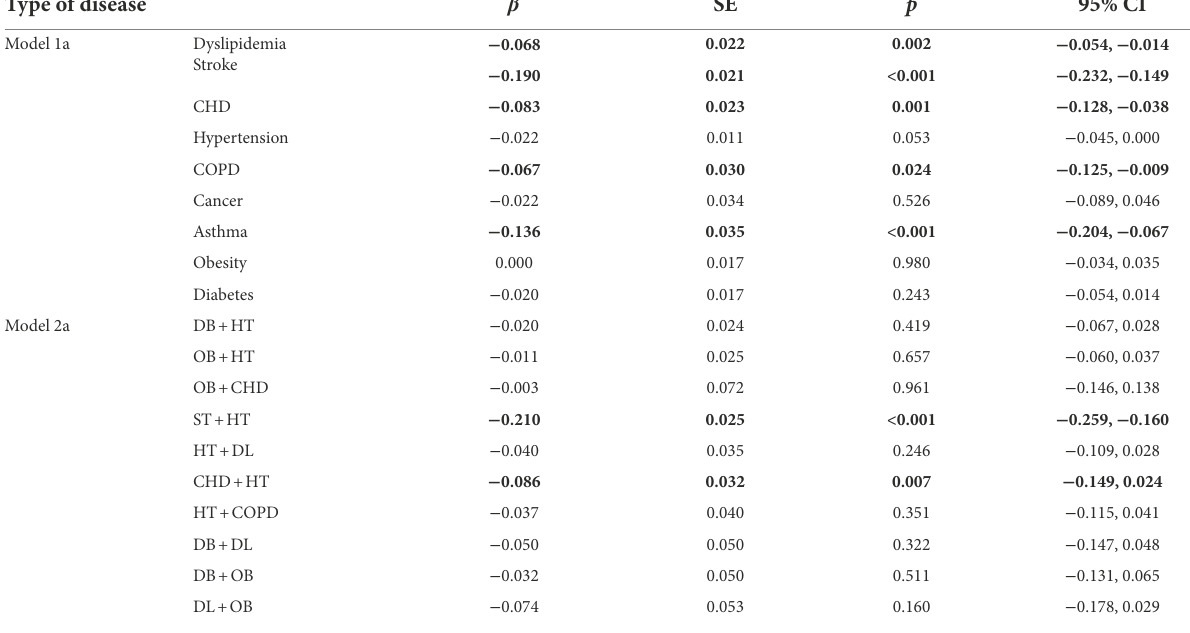
TABLE 2 Tobit regression results of the effects of single chronic diseases and multimorbidity combinations on EQ-5D index. Type of